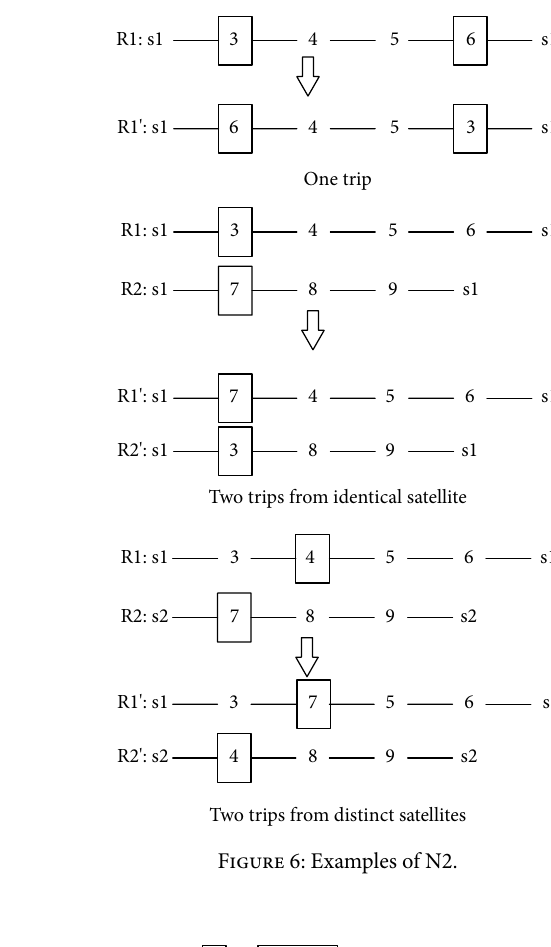
Figure 5: Examples of N1.